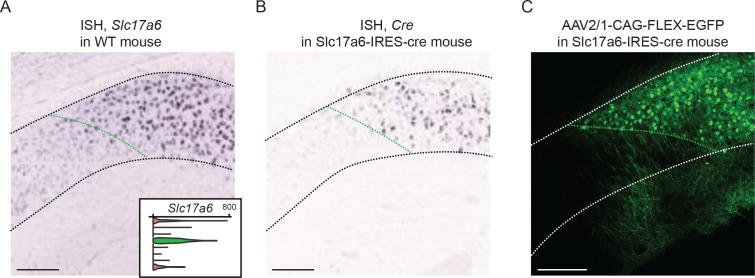
scRNA-seq results guide identification of cluster-specific transgenic mouse line.(A) ISH image depicting Slc17a6 expression (encoding Vglut2) in the dorsal subiculum of the mouse brain. Expression of this gene is located distally, but not proximally. Insert denotes scRNA-seq results, wherein Slc17a6 is enriched in the green population. Black dashed line denotes pyramidal cell layer. (B) ISH image depicting Cre expression in the Slc17a6-ires-cre transgenic mouse line. Black dashed line denotes pyramidal cell layer. Image from Allen Transgenic Characterization. (C) Viral expression following Cre-dependent AAV2/1-CAG-FLEX-EGFP viral injection into the dorsal subiculum. White dashed line denotes pyramidal cell layer. In all panels, green dashed line denotes approximate boundary associated with Slc17a6-enriched cluster. Scale bars: 200 μm.